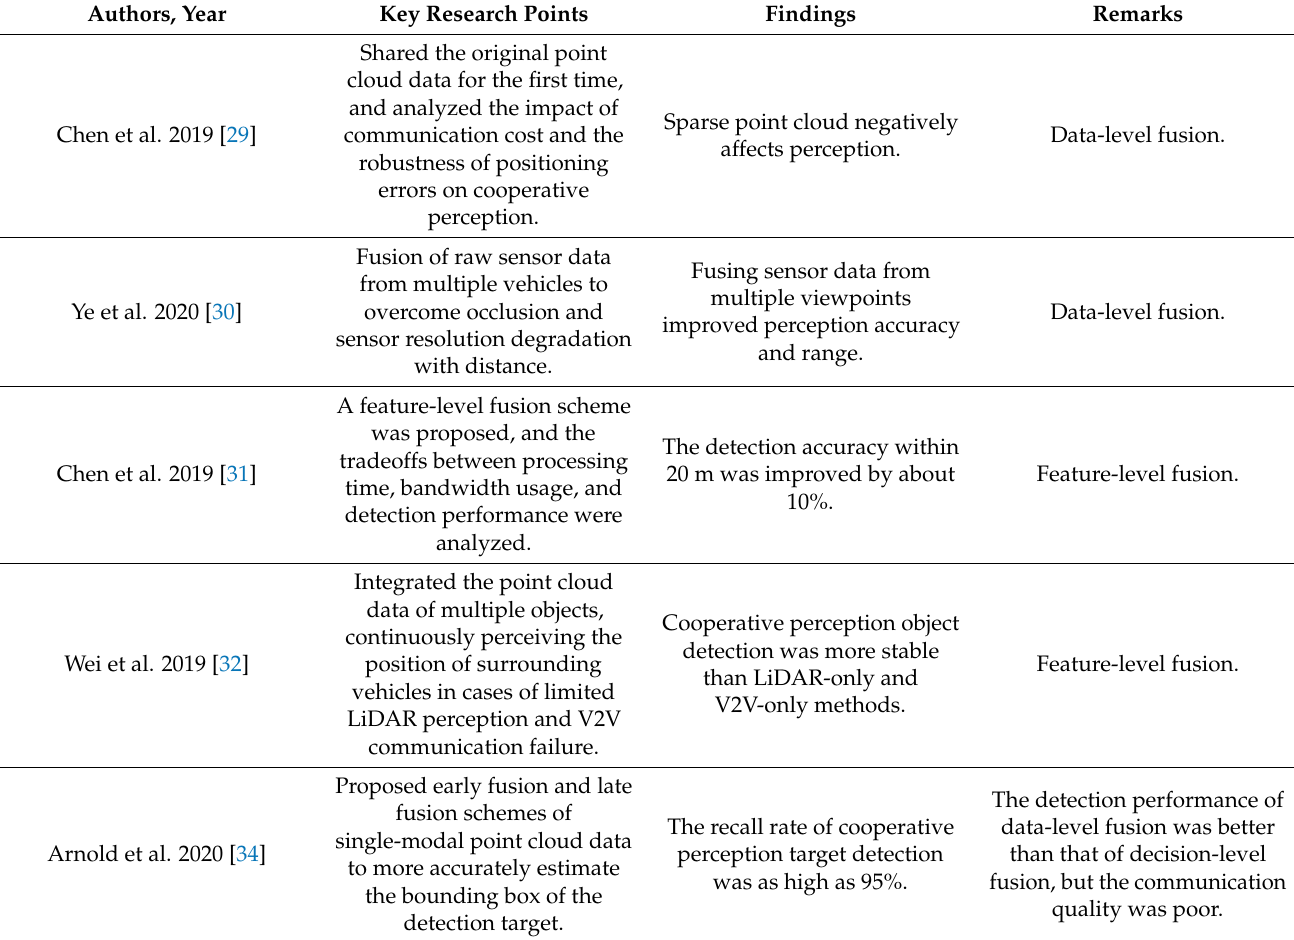
Table 3. Summary of recent studies on point cloud fusion methods.